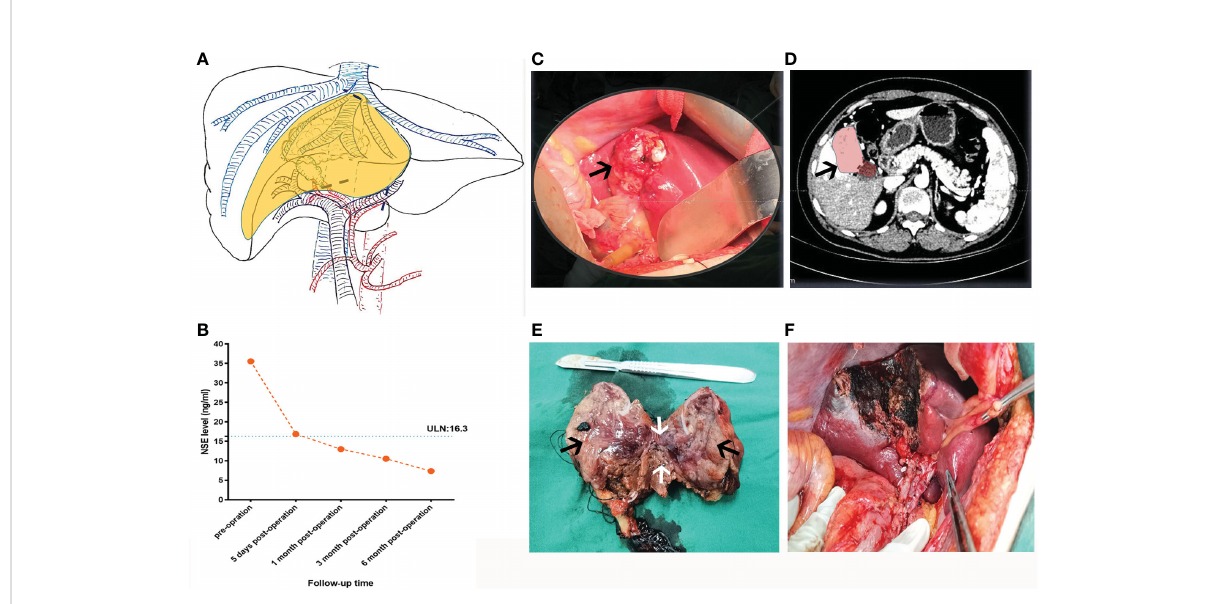
FIGURE 2 Preoperative planning and intraoperative status of patients. (A) According to the information from the two-dimensional enhanced CT image before operation, the hepatic lesion, the operative path (the black dotted line), and the resection area (the yellow area) were reconstructed by hand-drawing. (B) The tendency chart of NSE levels during patient follow-up. (C) Intraoperative gallbladder tumors (black arrow) and (D) corresponding CT images (black arrow). (E) Section of resected gallbladder tumor and part of the liver tissue, as shown, the black arrows indicate the gallbladder mass and the white arrow represents the liver tissue adjacent to the tumor (F) The wound condition after